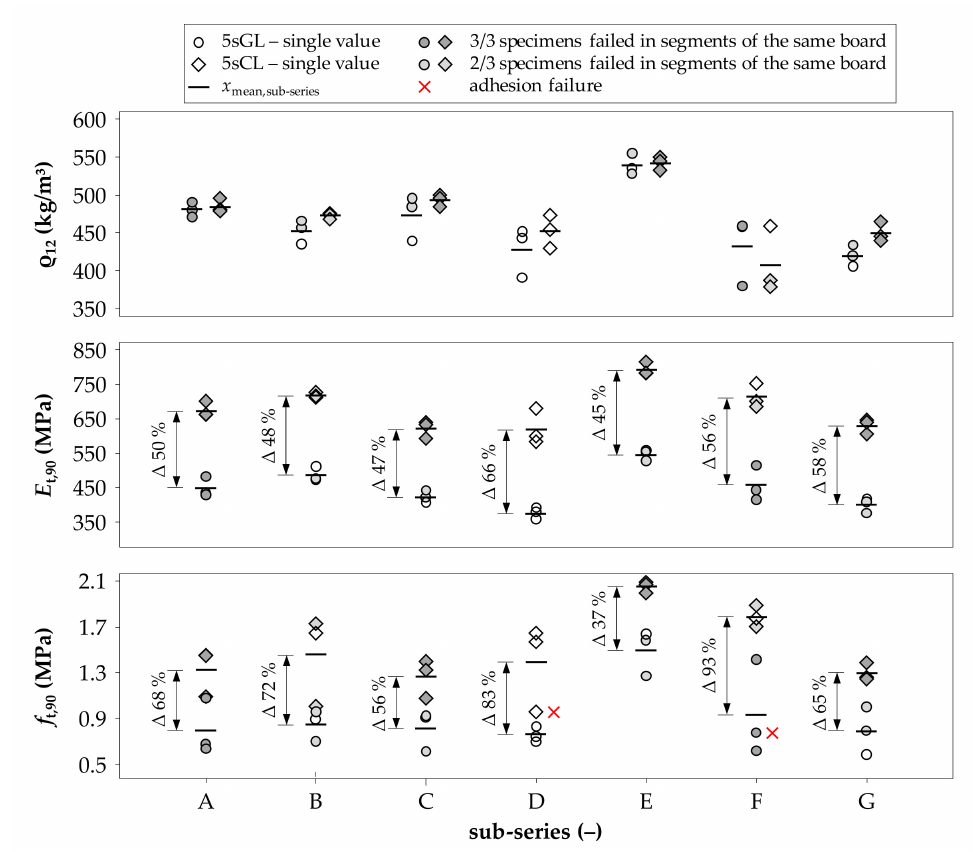
Figure 14. Analysis of sub-series in series 5sGL and 5sCL: ( above ) density; ( middle ) modulus of elasticity in tension out-of-plane; ( below ) tensile strength out-of-plane; single and mean values as well as identification of failed segments from the same